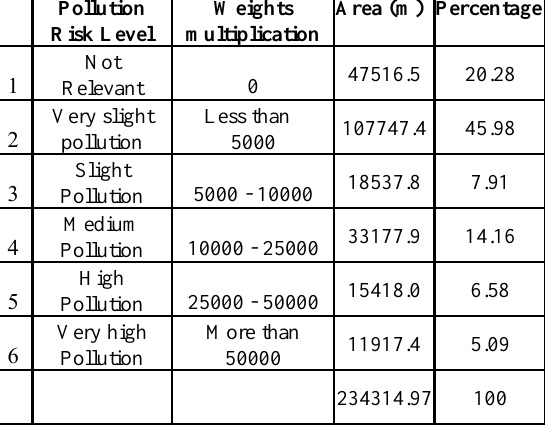
Table 3: surface water pollution risk classes, areas